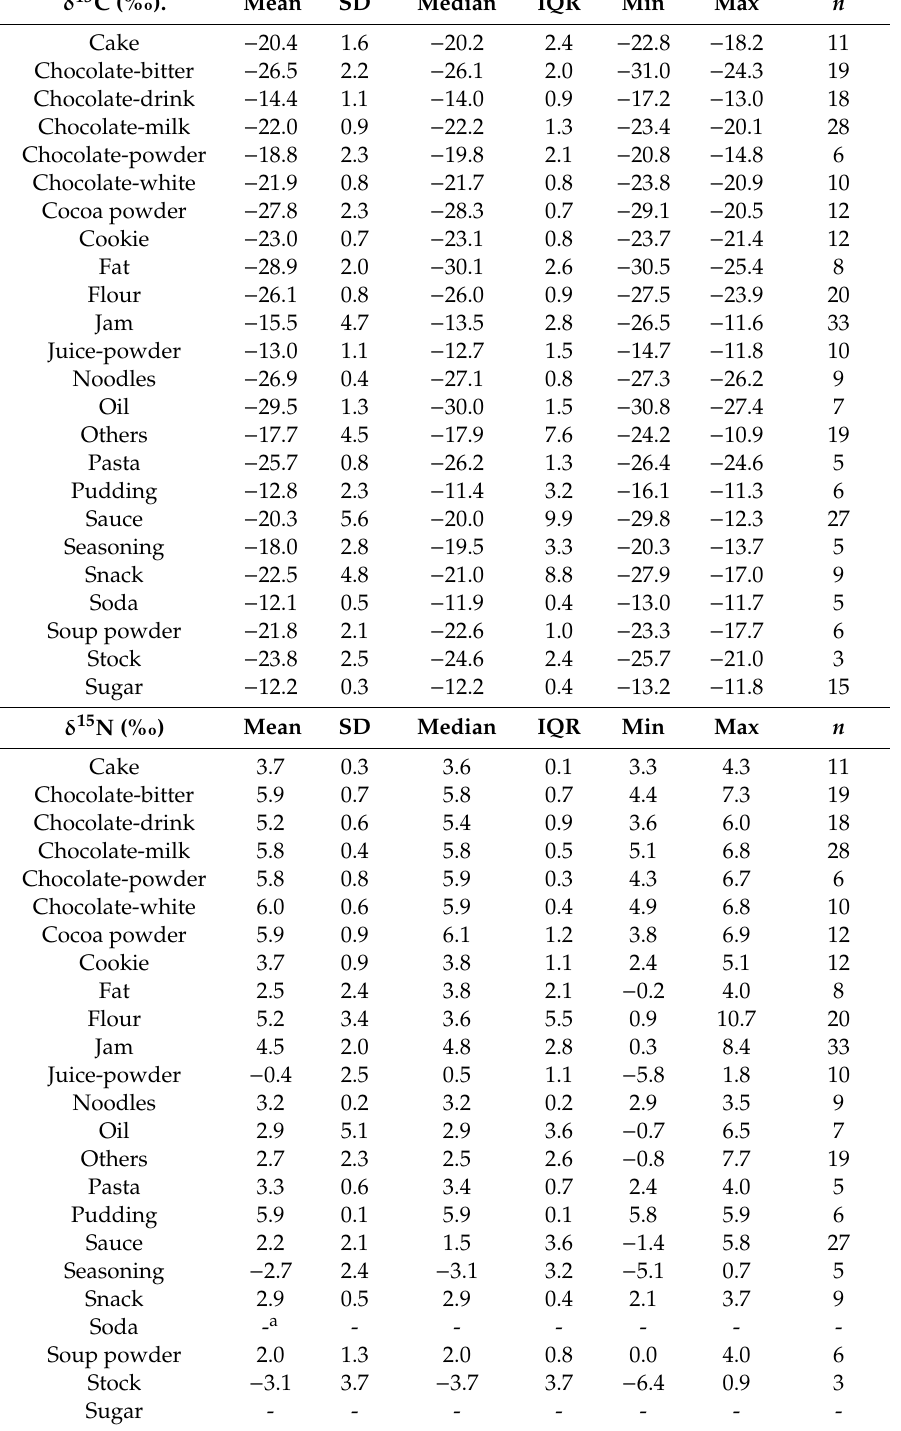
Table 1. Descriptive statistics* of δ 13 C and δ 15 N of plant-based processed foods. δ 13 C (% (cid:24)